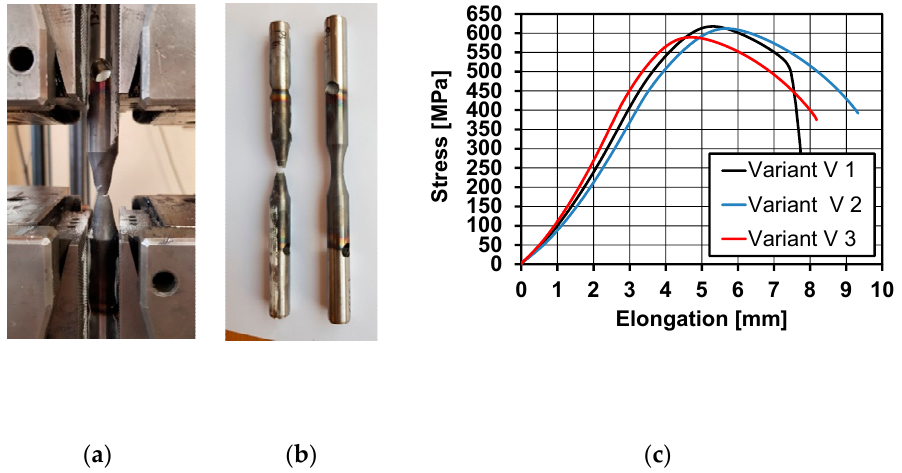
Figure 17. Sample results from testing the mechanical properties of the material after physical modelling of rolling a wire rod: ( a ) general view of a 20MnB4 steel sample after physical modelling, during determination of mechanical properties in a static tensile test, ( b ) general view of samples before and after the test, and ( c ) sample tensile curves of the tested material after physical